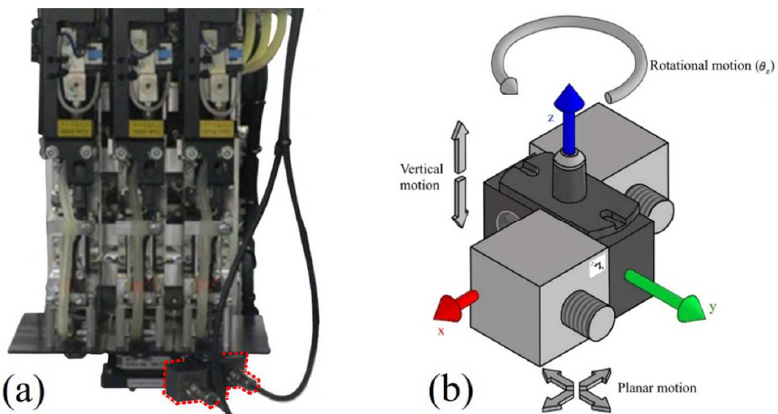
Figure 1. Assembly of nozzle and accelerometers: ( a ) detail of machine head with accelerometers highlighted with a red dotted line. ( b ) Graphical representation of machine/inertial referential frame and possible nozzle movements. Note: The nozzle has translational motion in the x , y, and z -directions and rotational motion in the z -direction.